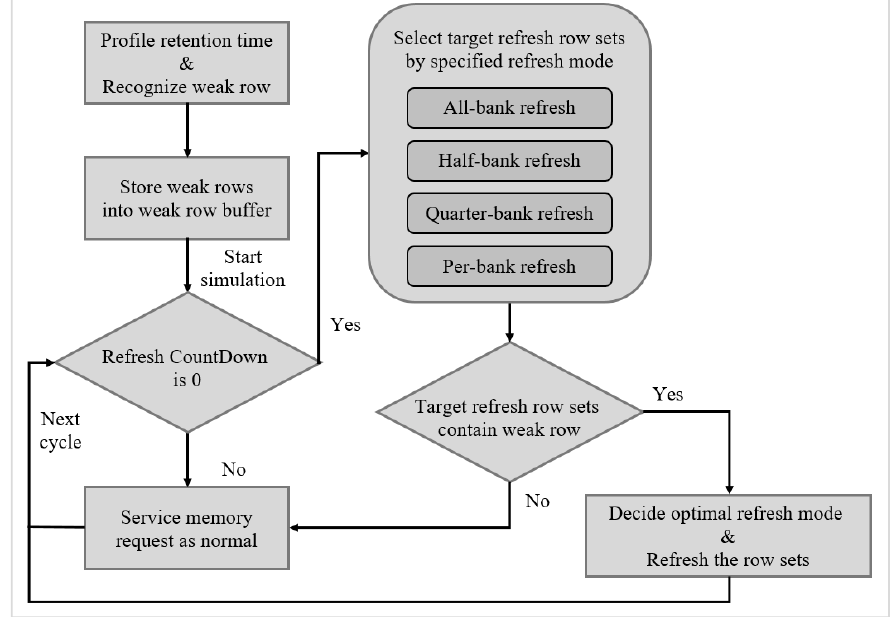
Figure 8. Proposed program flow.